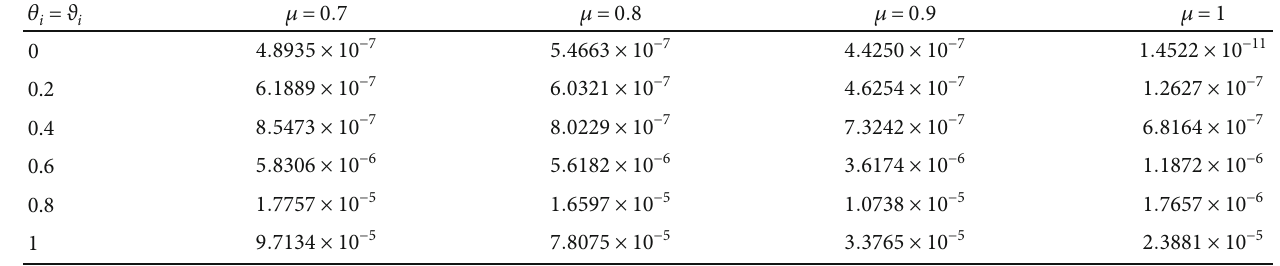
Table 2: Absolute errors for k